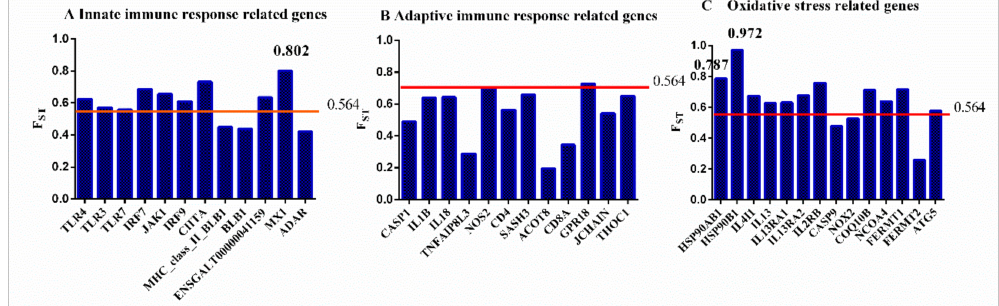
Figure 4. Fixation index (F ST ) values of immune response related genes: ( A ) F ST values of innate immune response related genes, ( B ) F ST values of adaptive immune response related genes, ( C ) F ST values of oxidative stress related genes. The red line represents the mean F ST value of all genes in the